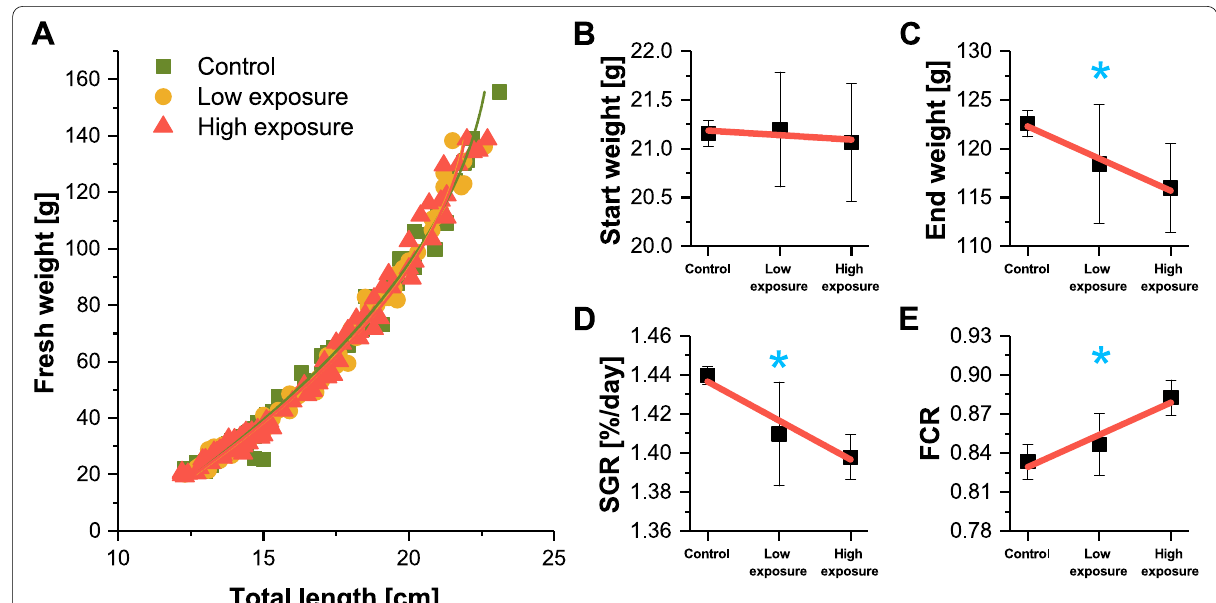
Fig. 3 Growth and performance parameters of rainbow trout for each treatment in the exposure experiment. (A) Relationship between total length and wet weight. (B) Mean weight ( standard deviation; SD) of fish at the beginning of the experiment. (C) Mean weight ( ± of the experiment. (D) Mean specific growth rate (SGR SD) of fish. (E) Mean feed conversion ratio (FCR ± significant dose dependent effect between treatments (contrast test, p < 0.05; for more details please refer to Table